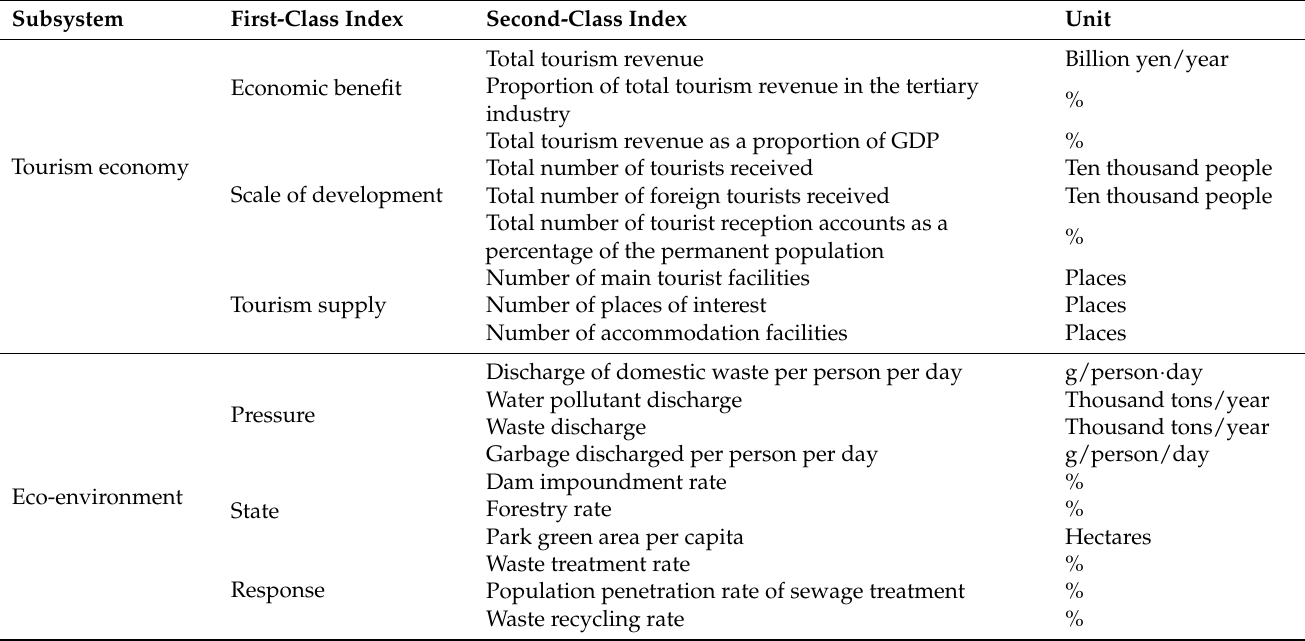
Table 1. Index system used for evaluation of the relationship between tourism economy and eco-environment.